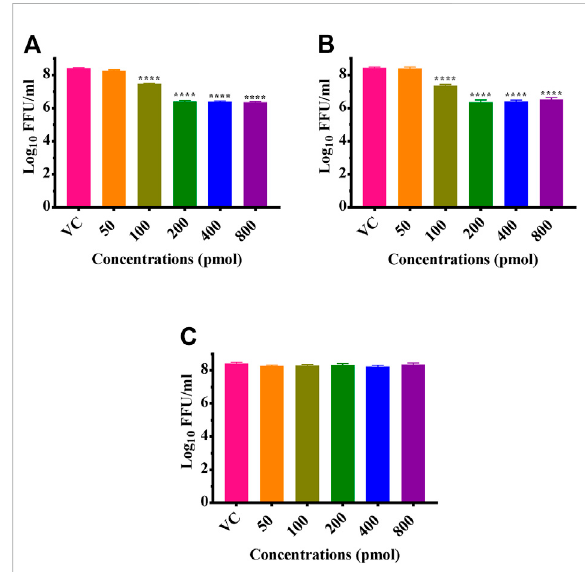
FIGURE 3 Dose dependent effects of ZIF-C siRNA formulations on CHIKV replication. Vero CCL- 81 cells were then infected with 0.01 MOI CHIKV for 1 h. Later, cells were treated with Chik1-ZIF-C (A) , Chik5-ZIF-C (B) and SARS-CoV-2-ZIF-C (C) immediately after infection for 6 hours and replaced by MEM with 2%FBS. The cells were incubated for 24 h post infection. Then plates were frozen and later FFU assay was done using the cell culture supernatant. Mouse anti-chikungunya antibody and goat anti- mouse IgG HRP conjugates were used as primary and